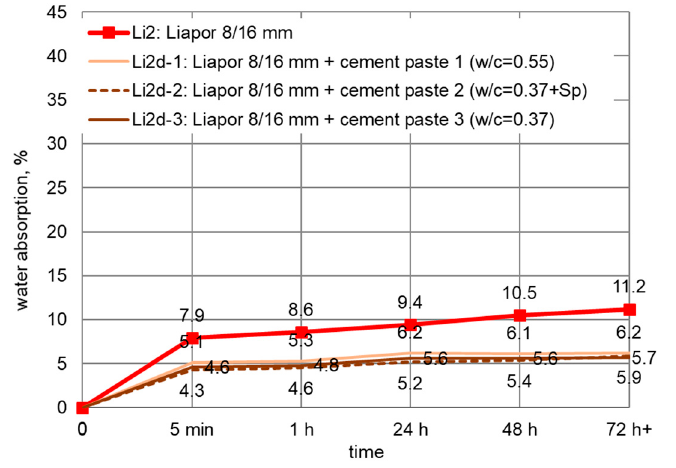
Figure 10. Development of water absorption in time for Liapor 8/12 mm impregnated with cement pastes.